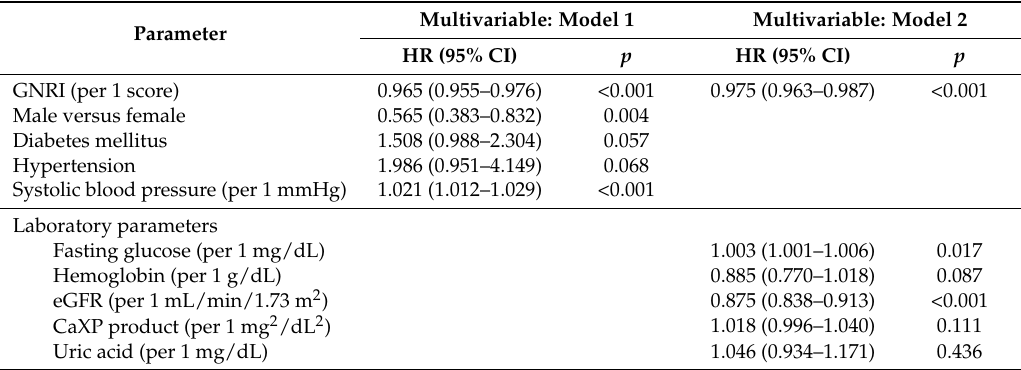
Table 5. Risk factors of progression to dialysis using the multivariable Cox proportional hazards